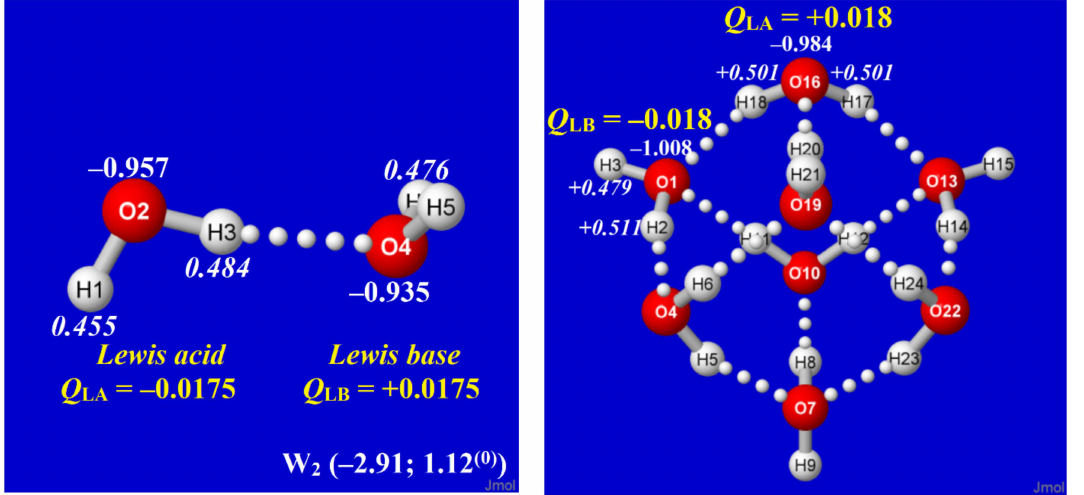
Figure 7. Natural atomic charges for H (italics; white) and O (plain text; white) atoms of water dimer ( left ) and cubane-like 0,8,0 W 8 cluster ( right ), with corresponding net charges (yellow) of formal Lewis acid ( e -acceptor) and Lewis base ( e -donor) water molecules in each species, showing the reversal of apparent charge flow in the two cases. (Parenthesized per-monomer energy and free energy for W 2 also allow direct stability comparisons with clusters of Figures